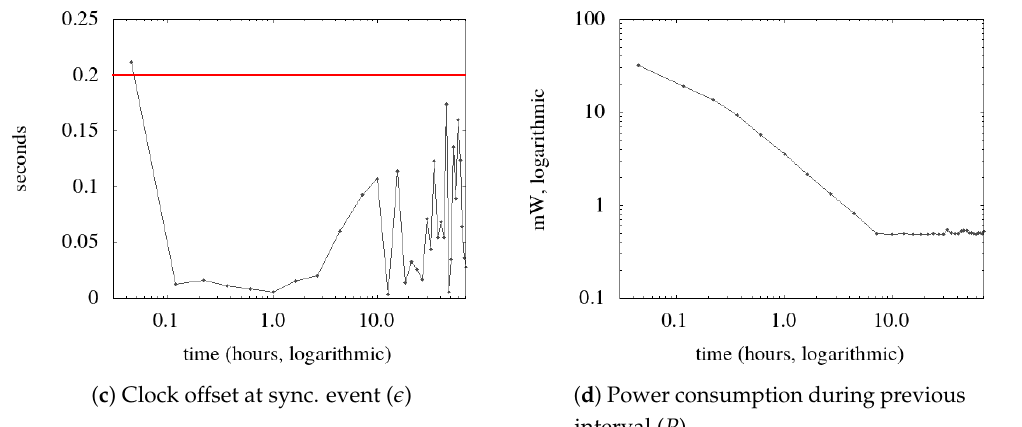
Figure 3. Results of the second experiment with an undocumented clone of the Arduino Pro Mini. To avoid the divergence shown in Figure 2, a 15ppm floor threshold has been introduced for drift uncertainty. Clock uncertainty ( a ) remains within the limits during the entire duration of the experiment (55 h). Power consumption ( d ) stabilizes around